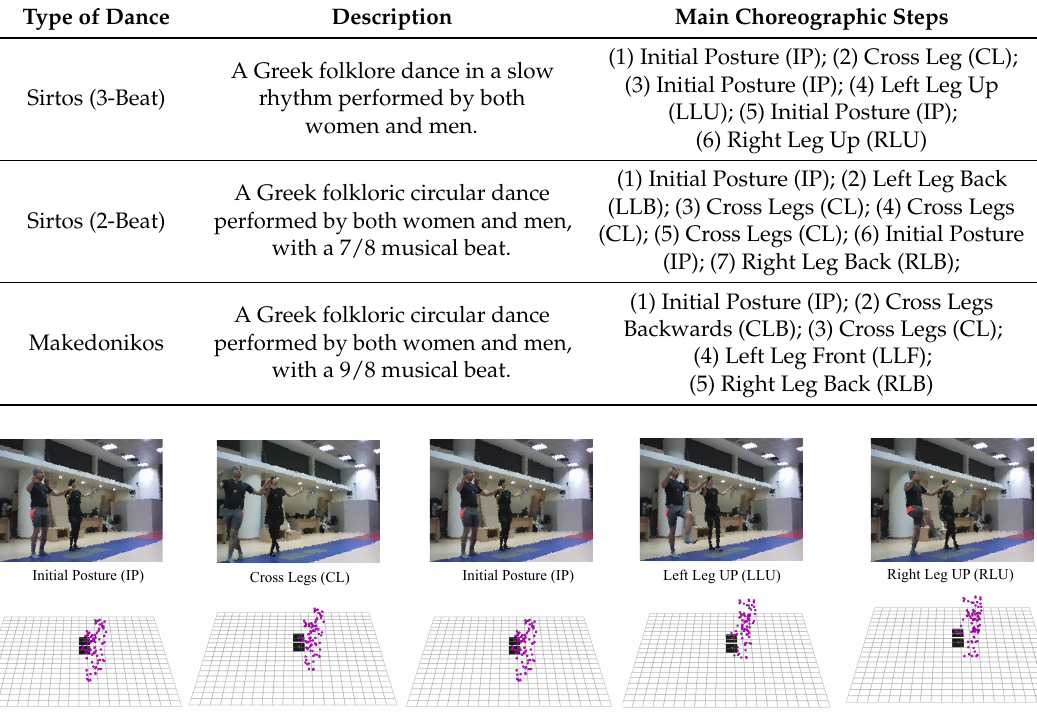
Figure 7. The main choreographic steps of Syrtos (3-beat)